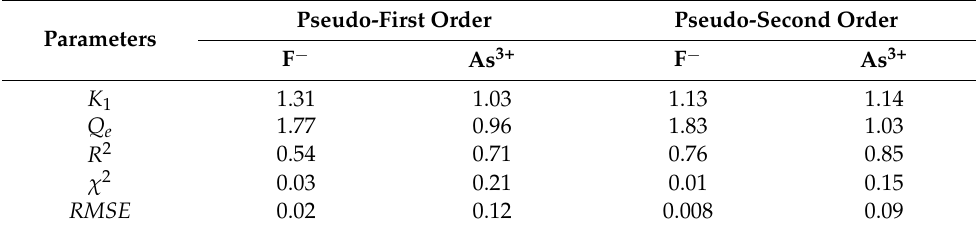
Table 3. Table for non-linearized kinetic parameters of F − and As 3+ onto the Fe-pPD composite.